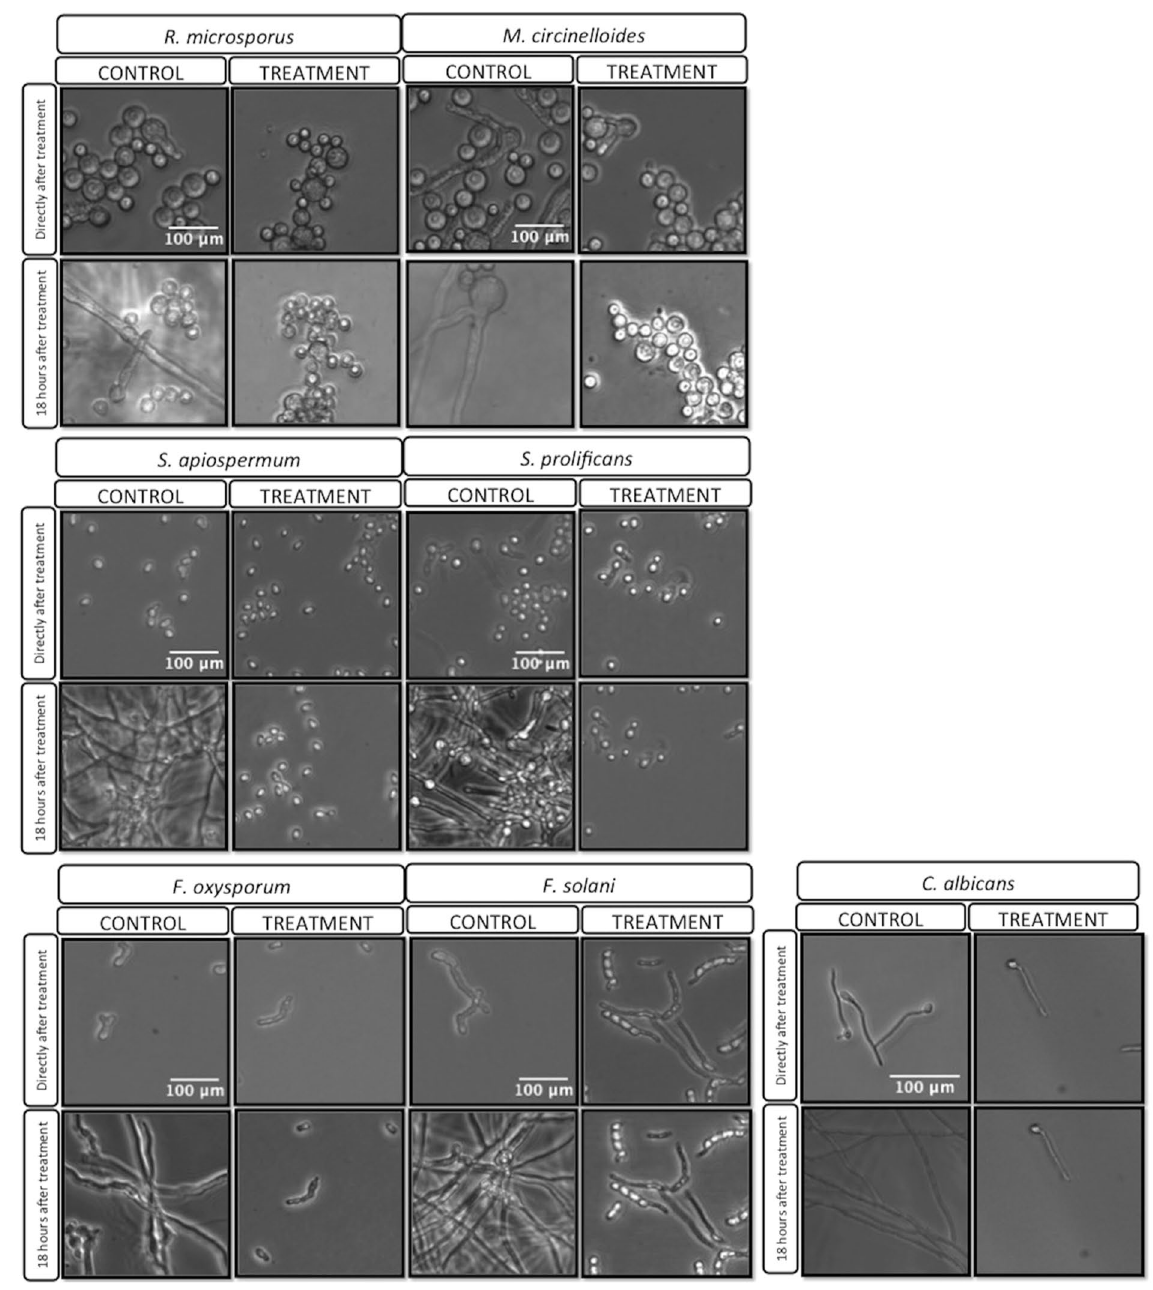
Figure 5. 60 min (216J/cm 2 ) blue light treatment show antifungal activity on pregerminated spores. Time-lapse imaging shows inhibition of further fungal growth after blue light